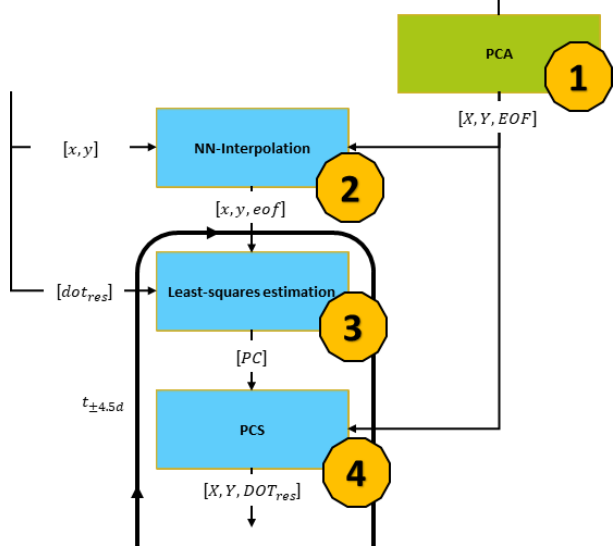
Figure 6. Subset of Fig. 4, outlining combination steps. Numbers indicate the chronological order of the individual processing